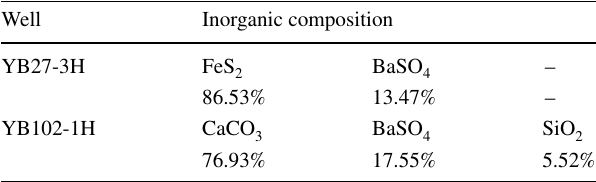
Table 3 Results of energy spectrum analysis of the blockage